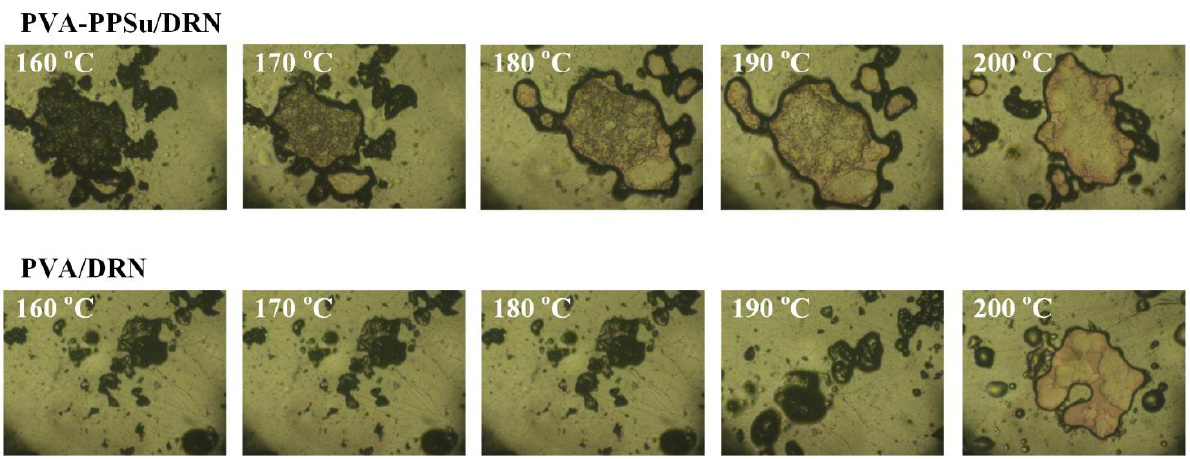
Figure 9. HSM images during melting of the PMs of PVA-PPSu/DRN and PVA/DRN (at a matrix-carrier to API ratio of 30/70% w / w ).